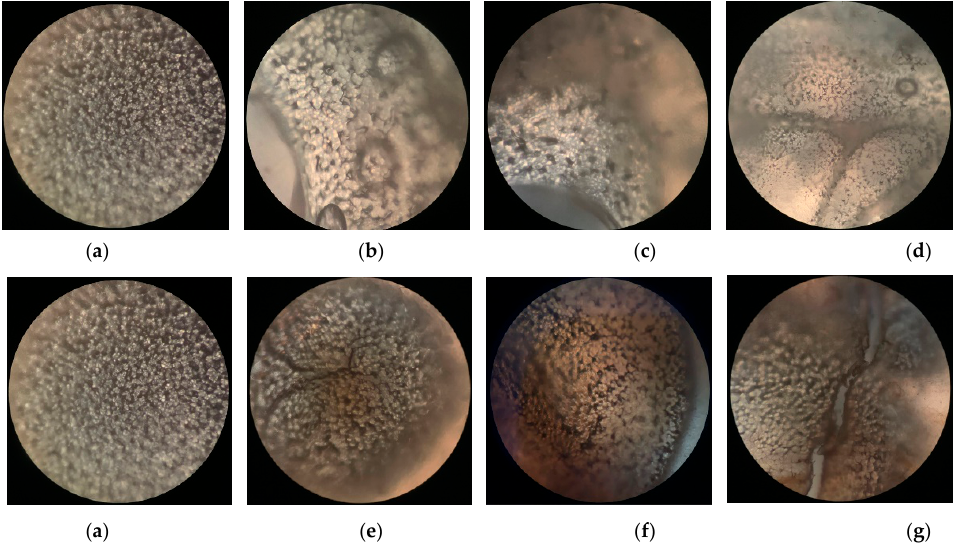
Figure 6. The polarizing microscope photographs of PLLA films before and after immersion in PDLA or PDLAG solution: ( a ) PLLA; ( b ) m − PLLA − 1; ( c ) m − PLLA − 2; ( d ) m − PLLA − 3; ( e ) m − PLAG − 1; ( f ) m − PLAG − 2; ( g ) m − PLAG − 3.